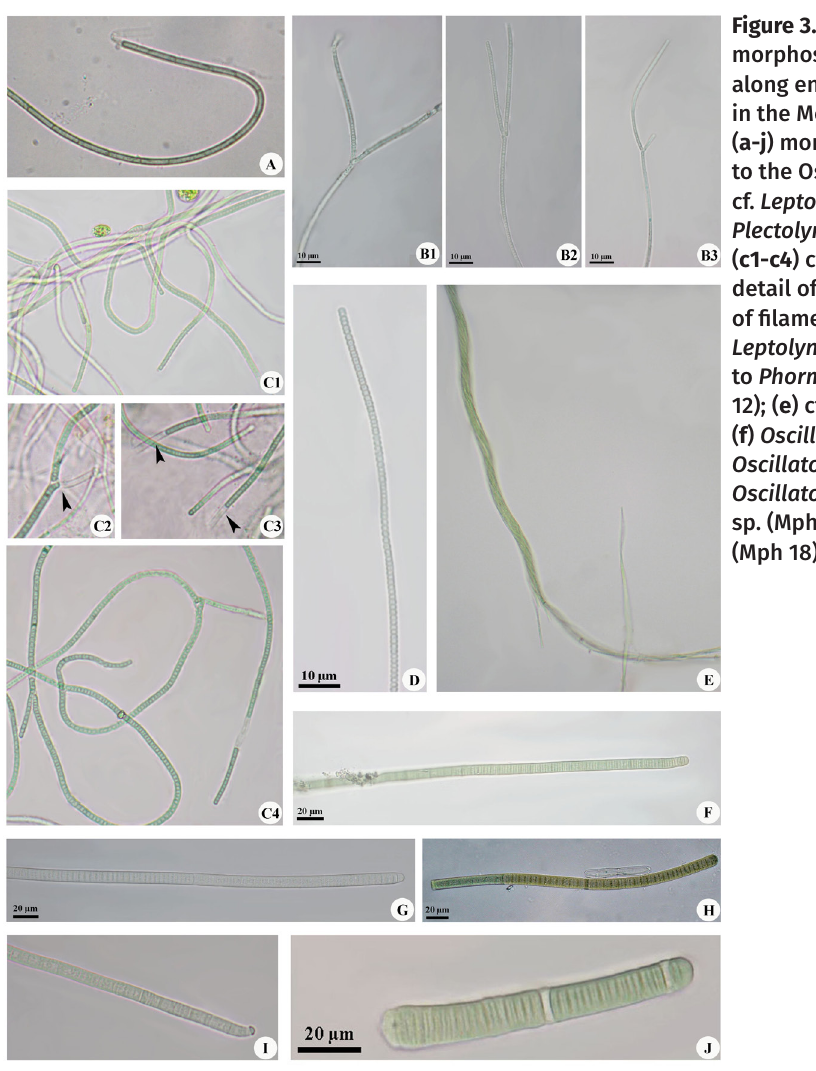
Morphotype 4 (Fig. 2d1-d2)